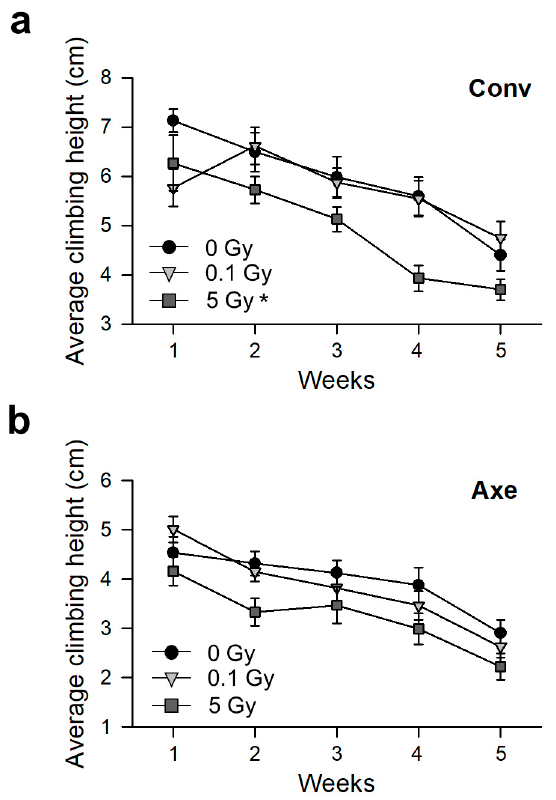
Figure 4. Effects of commensal microbes on the physical activity of Conv ( a ) or Axe ( b ) D . melanogaster after γ -ray irradiation. The physical activity was measured by assaying the vertical climbing behavior of the Conv or Axe flies after γ -ray irradiation. The line with circles indicates the non-irradiated flies, the line with inverted triangles indicates the 0.1 Gy irradiated flies, and the line with squares indicates the 5 Gy irradiated flies. Two-way repeated measures ANOVA with Tukey’s post hoc test, * p < 0.05. Error bars represent the SEM.